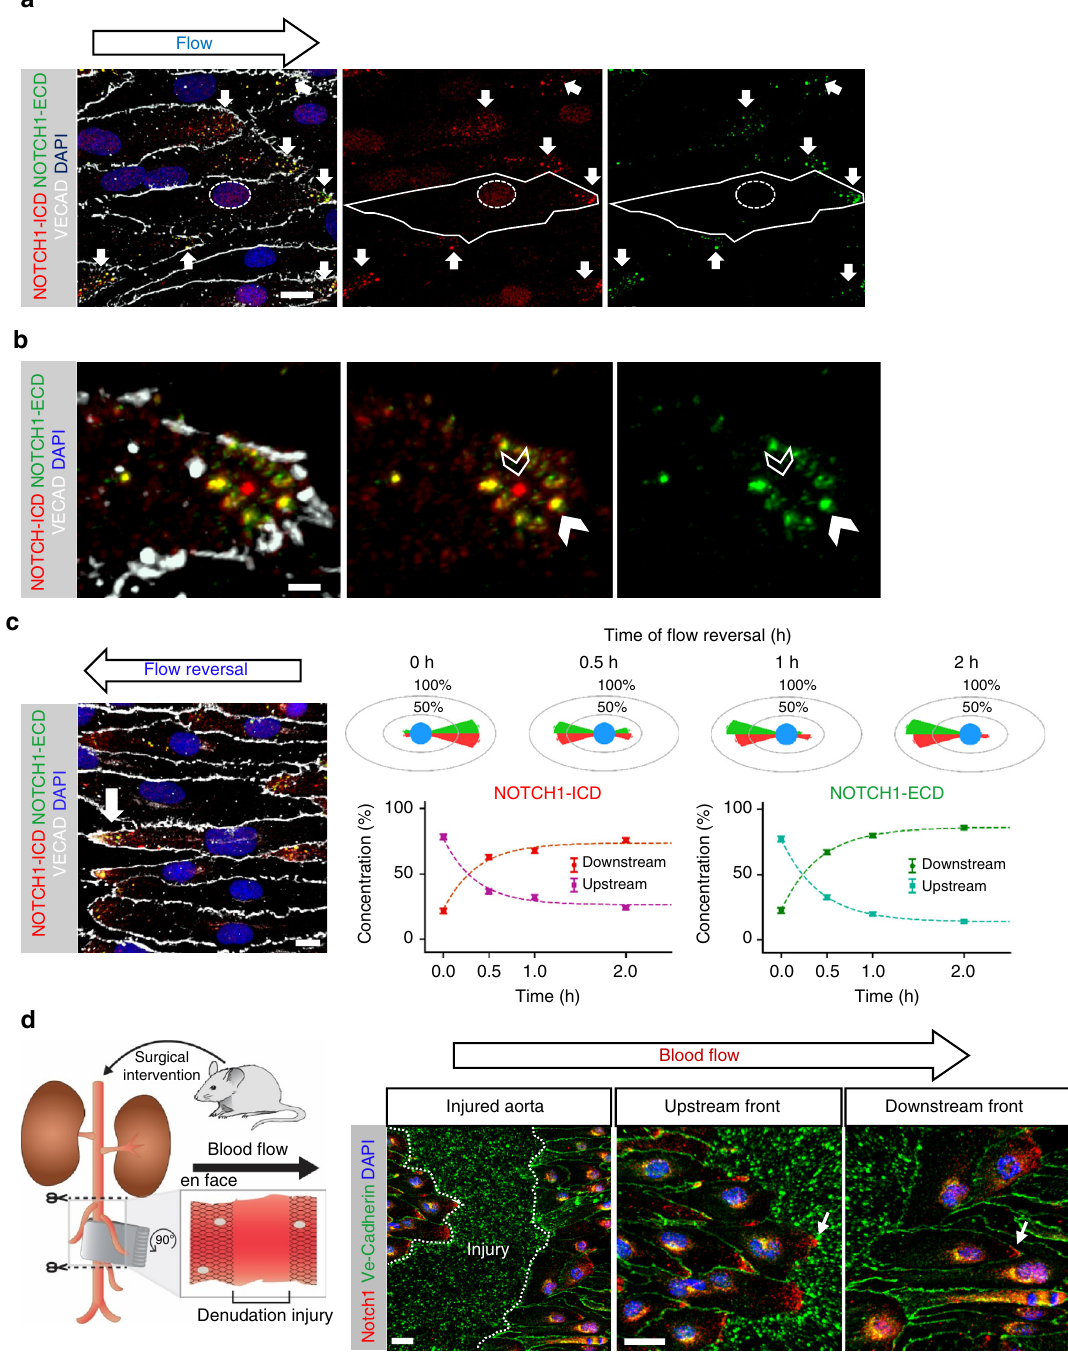
Fig. 3 NOTCH1 is polarized downstream of fl ow. a Endothelial cells (HAECs) subjected to high laminar fl ow (20 dynes cm − 2 ) display signi fi cant cellular elongation, revealed by VECAD (white) and distribution of NOTCH1 intracellular domain (ICD, red) and extracellular domain (ECD, green) at the downstream pole downstream pole, as marked by solid white arrows. Dashed line marks a cell nucleus con fi rming the nuclear presence of NOTCH1 ICD without ECD. Scale bar = 10 µ m. b Downstream pole of an endothelial cell subjected to high laminar fl ow showing NOTCH1 ECD (green) and ICD (red). Co- localization of ECD and ICD is indicated by the solid arrowhead and intracellular activated NOTCH1 is marked by the open arrowhead; scale bar = 3 µ m. c Upon fl ow-direction reversal, NOTCH1 ICD and ECD protein redistributes to the new downstream pole; scale bar = 10 µ m. Kinetics of the protein redistribution was measured and the typical time for repolarization (dashed lines) was ~30 min ( n ≥ 116 individual cells for each time point measured). d Arterial denudation injury of wildtype (C57BL/6) adult mouse to generate injury region (marked by dotted white line) with two migrating endothelial fronts. Note the presence of Notch1 (marked by white arrows) at the downstream pole of the cell regardless of migration direction (at least 40 cells at the wound margins were evaluated in three distinct wounded animals). Scale bars = 20 µ